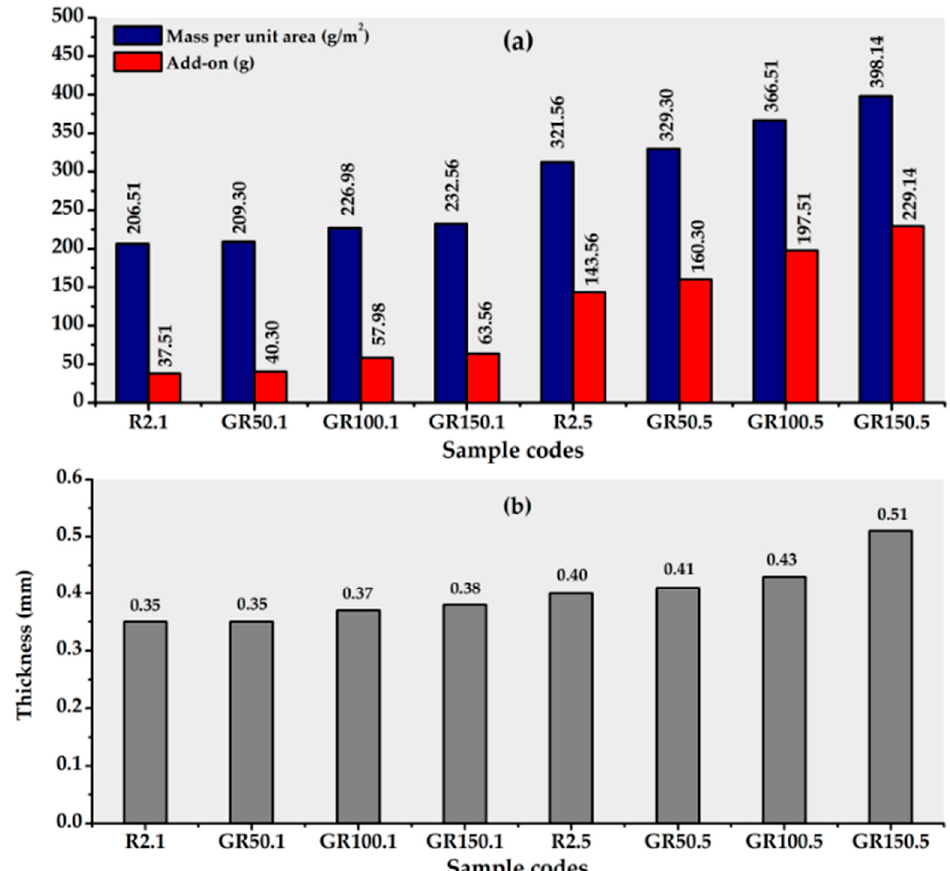
Figure 4. Mass per unit area and add-on results ( a ) and thickness results of reference and graphene-coated fabrics ( b ).